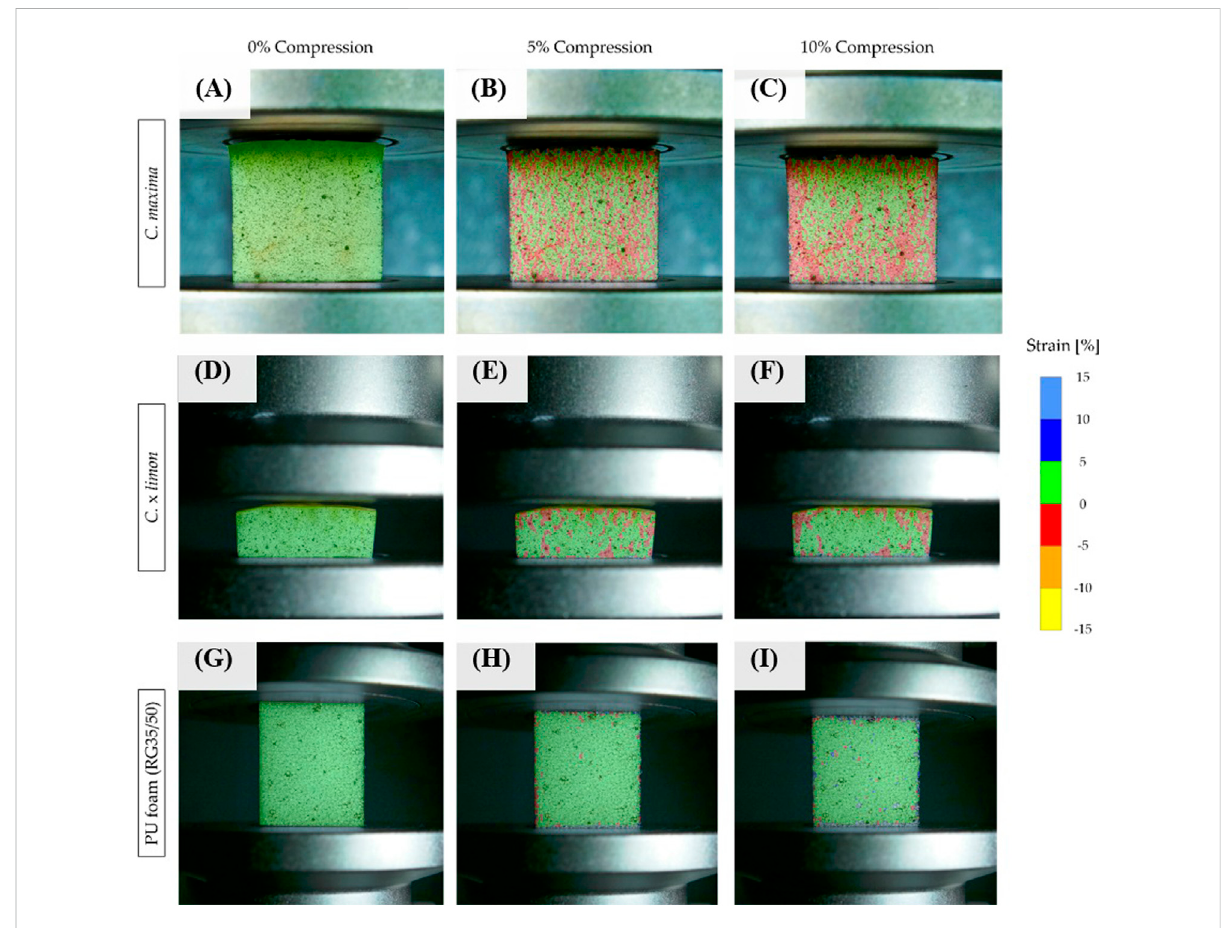
FIGURE 9 Visualization of the strain in lateral direction via GOM Correlate 2019 software. Characteristic deformation patterns up to an axial strain of 10% for (A – C) pomelo ( C. maxima ) (D – F) lemon ( C. x limon ), and (G – I) PU foam